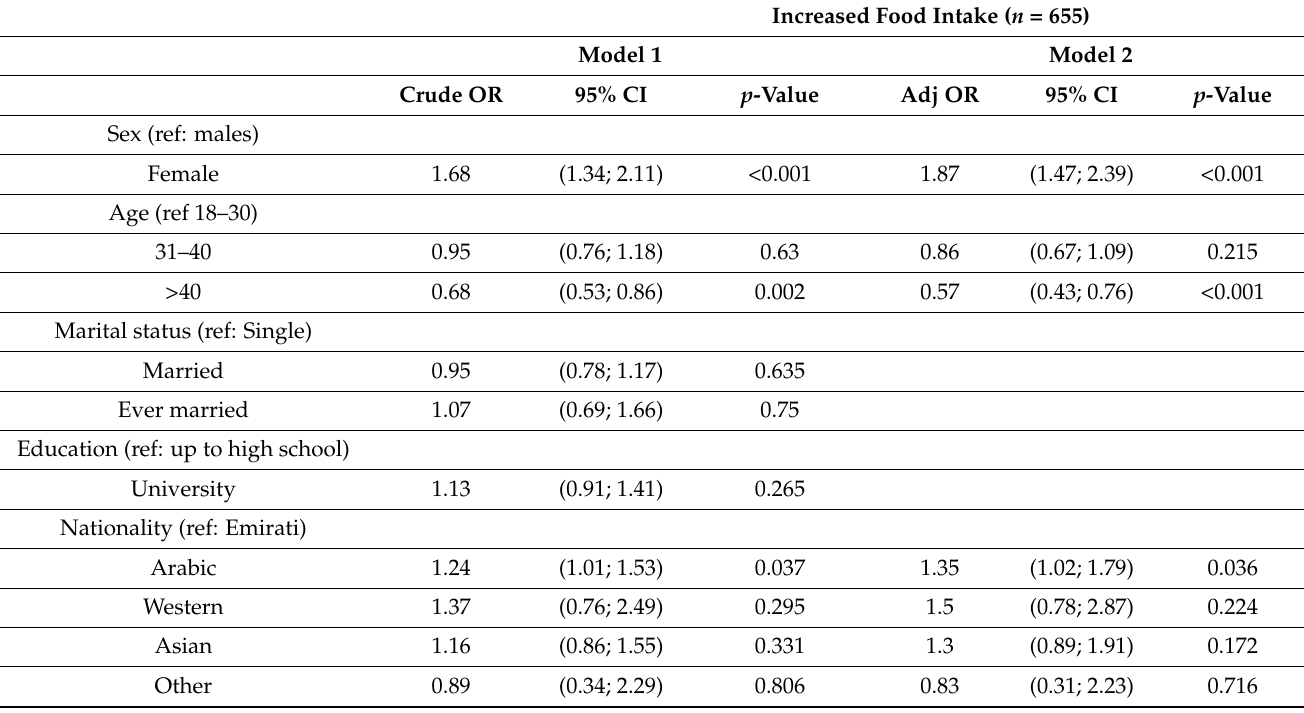
Table A1. Simple and multiple logistic regressions describing the association between increased food intake and sociodemo- graphic characteristics in the study population ( n =